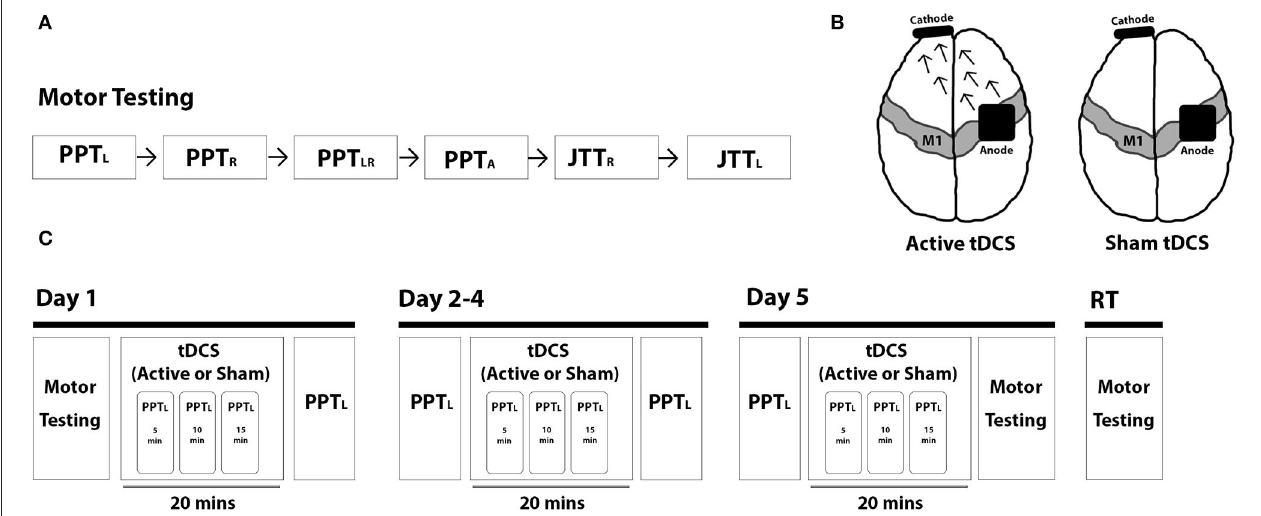
FIGURE 1 | Trial protocol. (A) Motor skill testing included the Purdue Pegboard Test (PPT) (left-handed: PPT L , right-handed: PPT R , bimanual: PPT LR , assembly: PPT A ) and the Jebsen-Taylor Test of Hand Function (JTT) (right-handed: JTT R , left-handed: JJT L ). (B) Intervention groups included 1mA anodal tDCS (left; arrows represent the direction of current flow from anode to cathode) and sham tDCS (right). (C) Study protocol is shown broken down by each intervention day (day 1–5) and for retention testing (RT) at 6-weeks